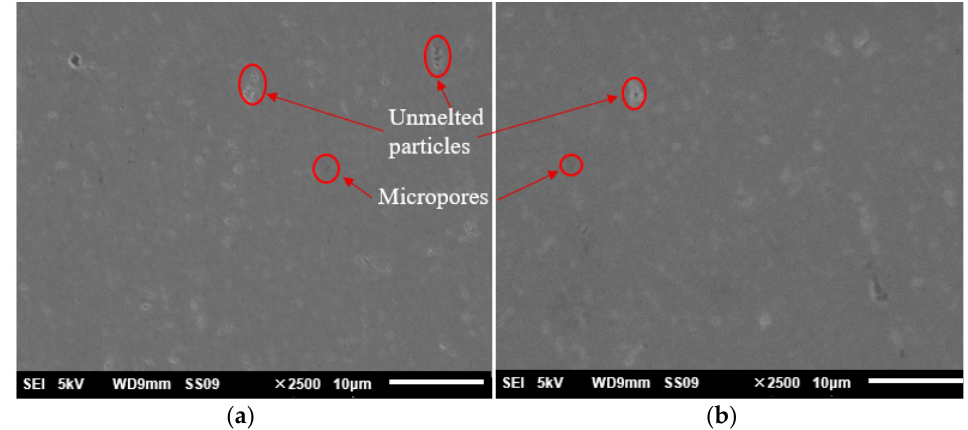
Figure 11. SEM micrograph of the mirror surfaces: ( a ) result at first point; ( b ) result at second point.